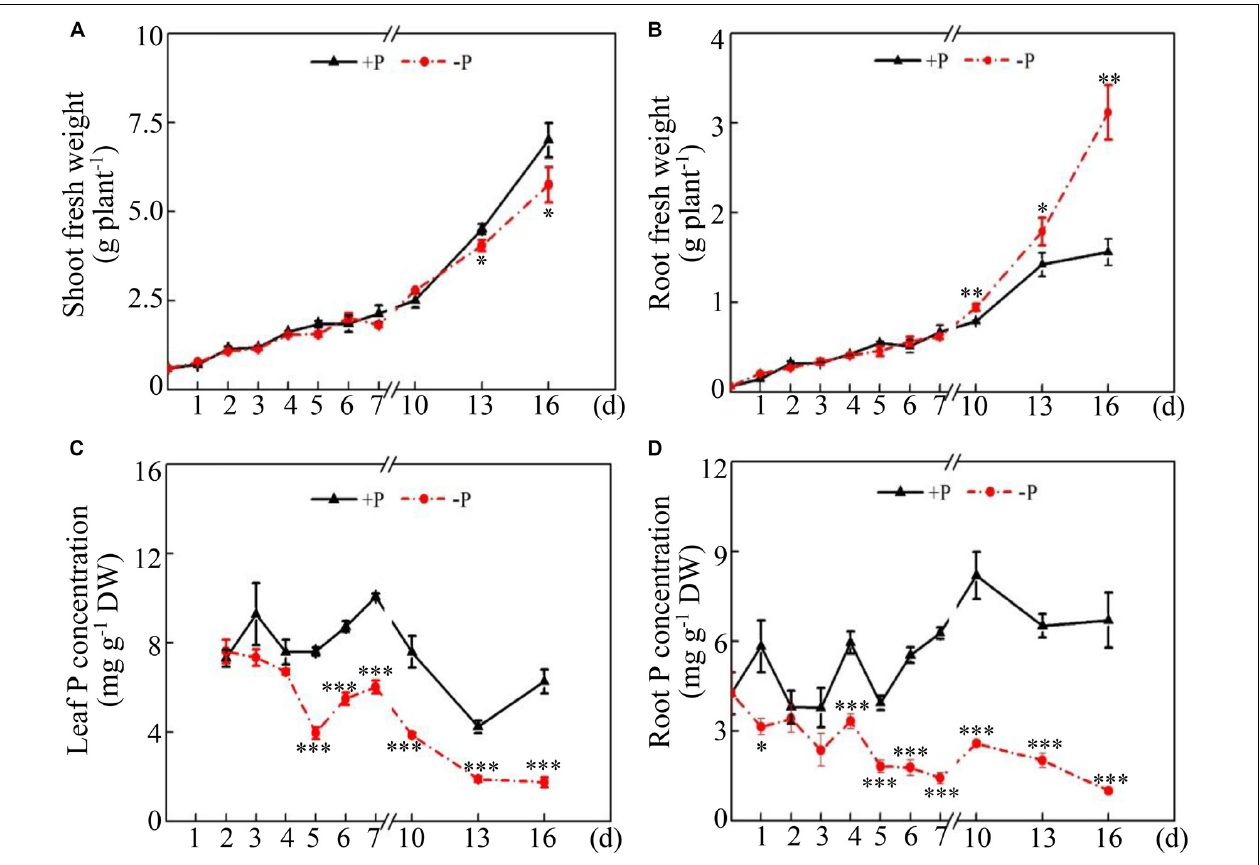
FIGURE 1 | Dynamic changes in soybean growth and P concentration at two P levels. (A) Shoot fresh weight. (B) Root fresh weight. (C) Leaf P concentration. (D) Root P concentration. Soybean seedlings were grown in nutrient solution supplemented with 5 µ M (–P) or 250 µ M (+P) KH 2 PO 4 . Fresh weight and P concentration were dynamically measured. The data are the means of four replicates with standard errors. The asterisks indicate significant differences between the –P and +P treatments according to Student’s t -test: ∗ P < 0.05; ∗∗ 0.001 < P < 0.01; ∗∗∗ P <